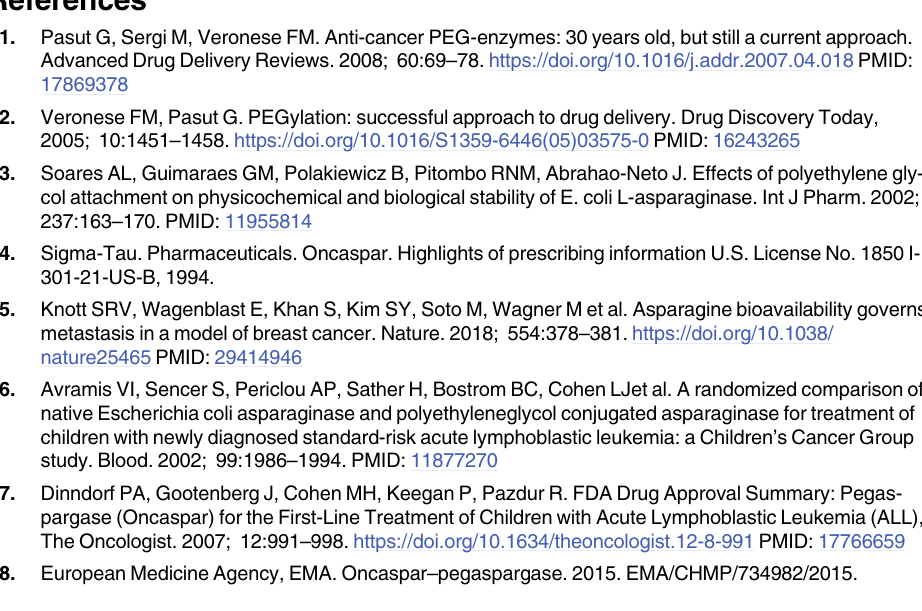
S9 Fig. Cytotoxicity of monoPEG-ASNase in HUVEC cells. Assays performed at 48 and 72 h, with cells alone (control), without enzyme (PBS) and enzyme concentrations measured in activity (0.01, 0.05, 0.1, 0.3 and 0.6 U � mL -1 ) . Gray bars - free ASNase, white bars—mono- pegylated ASNase. Error bars represent the standard